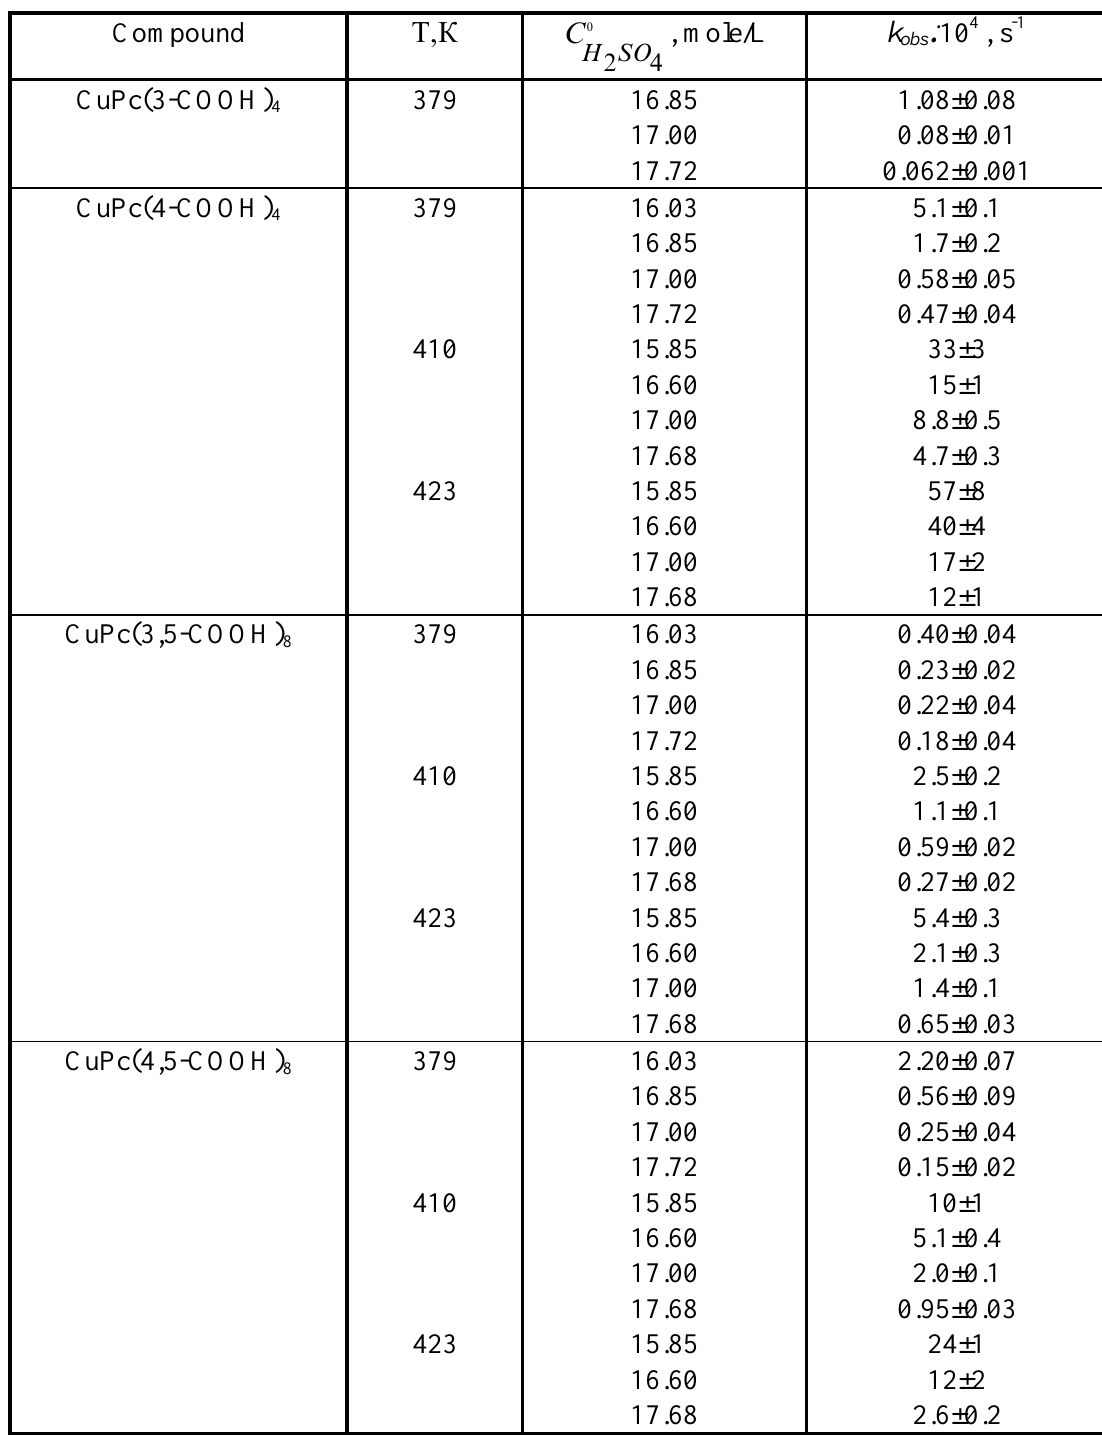
Table 3. Kinetic parameters of dissociation reactions of carboxy derivatives